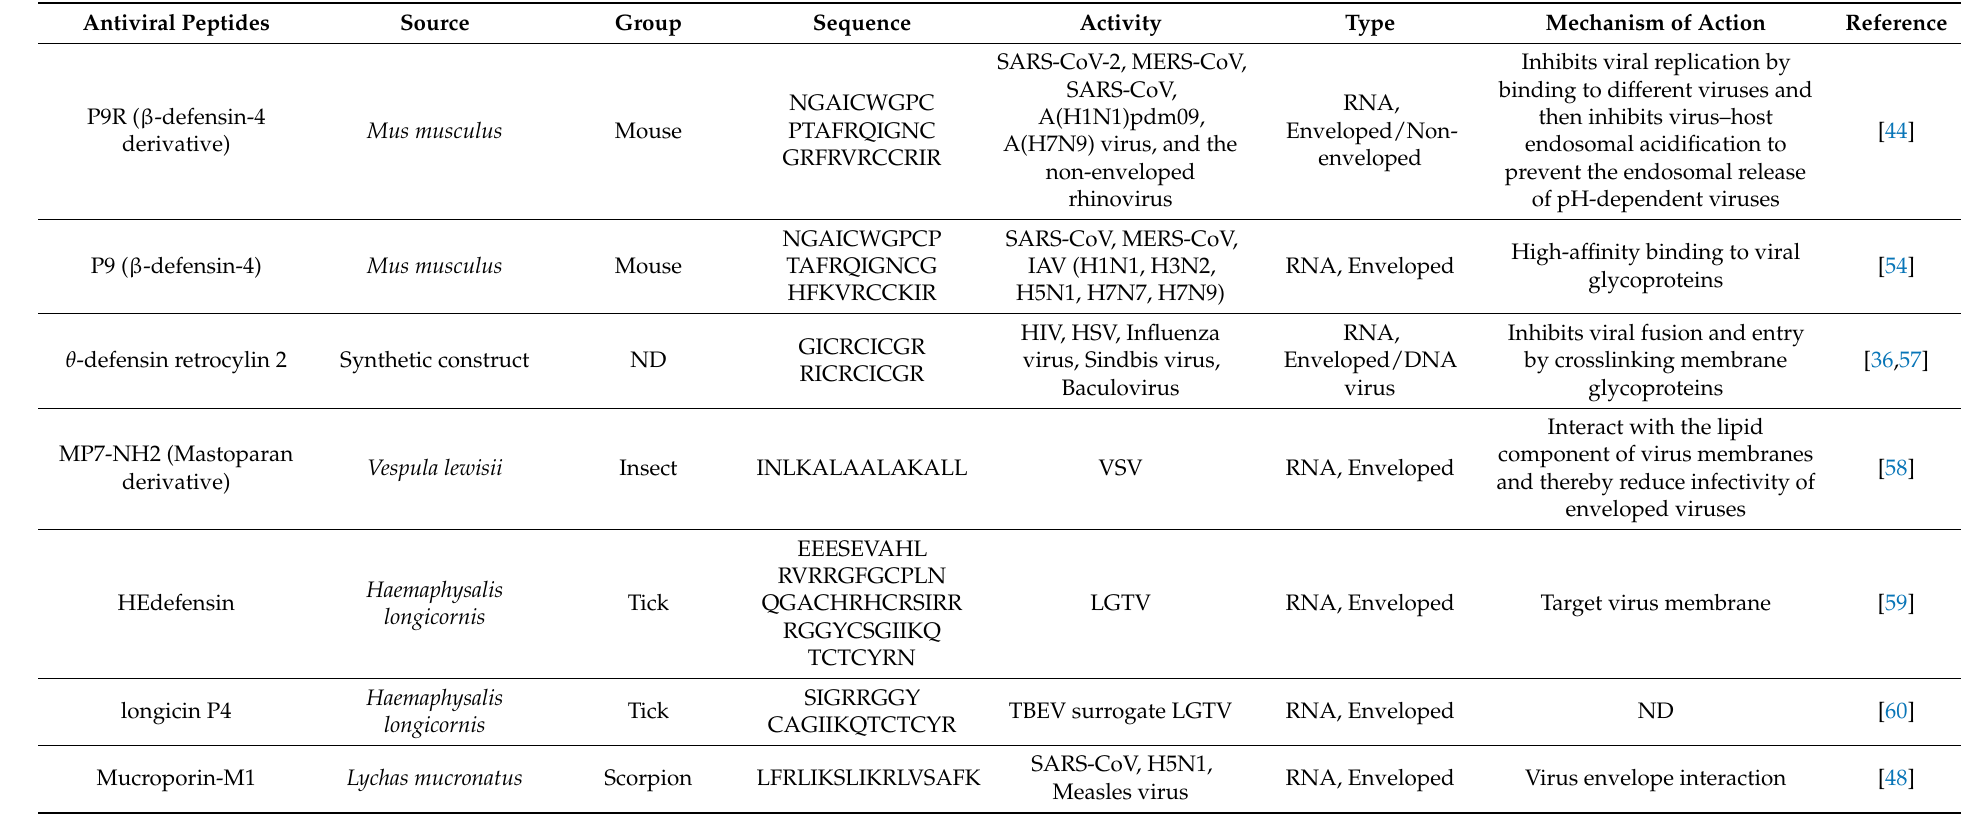
Table 1. Antimicrobial peptides with antiviral